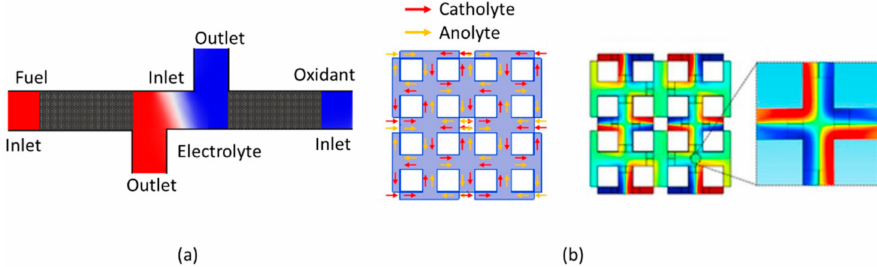
Figure 8. CFMMFCs: ( a ) CFMMFC with fuel and oxidant inlets and an extra electrolytic inlet, and ( b ) CFMMFC network with multiple inlets and outlets (reprinted from ref. [137]. Copyright 2018